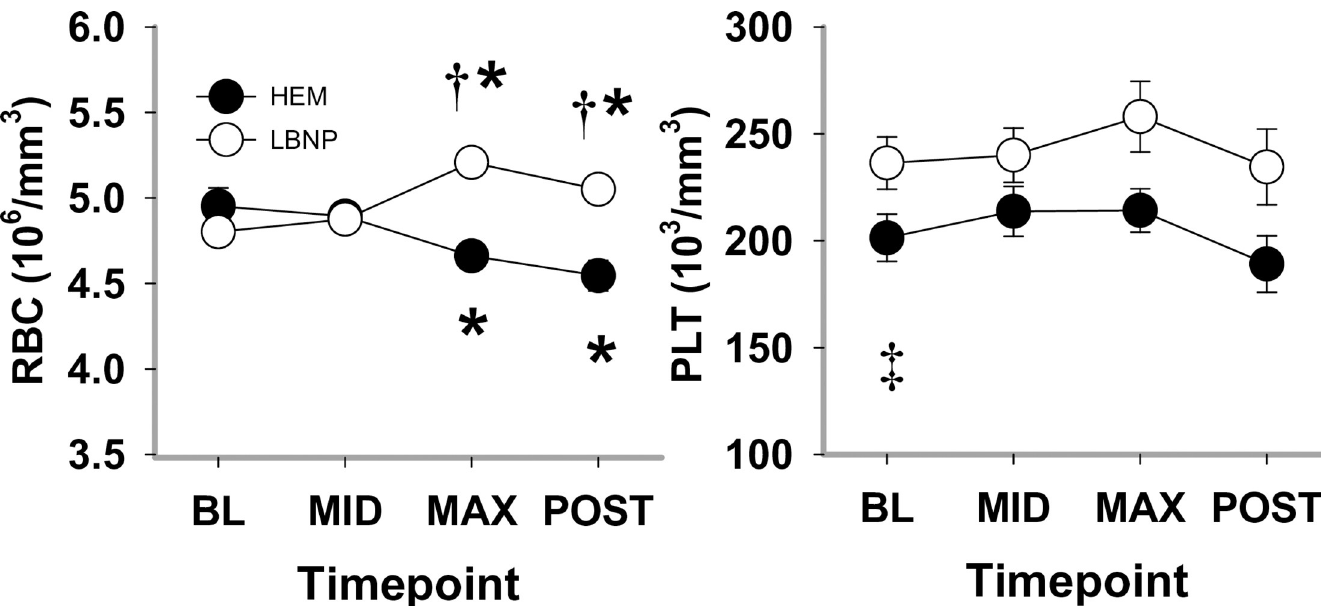
Fig 2. Red blood cell (RBC) and platelet (PLT) counts during HEM and LBNP in anesthetized baboons. Mean ± SE, n = 13; � different from baseline ( P < 0.05); † different from blood removal ( P < 0.05); ‡ different between trials.